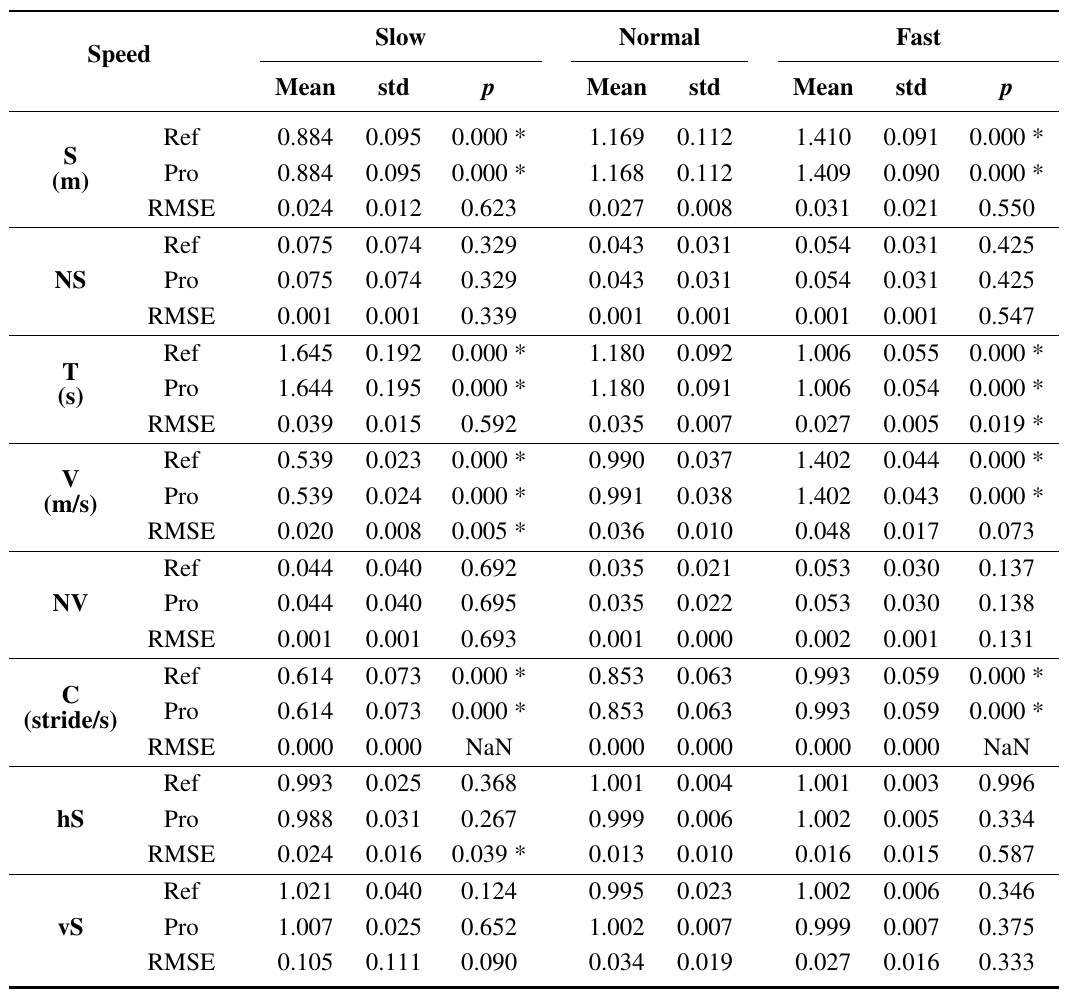
Table 8. Foot parameters at different walking velocities, ∗ indicates the significant differences with normal speed ( p < 0.05).